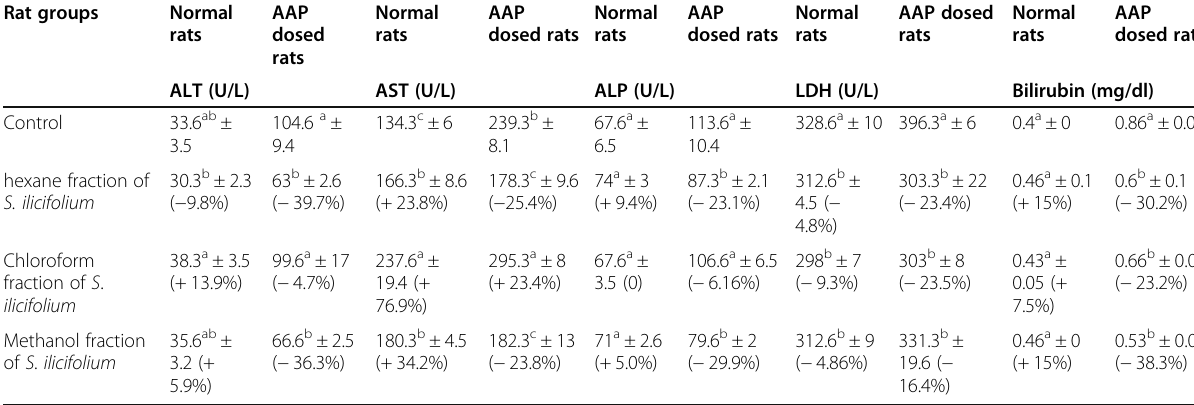
Table 1 Effect of n -hexane, chloroform and methanol soluble fractions of Sargassum ilicifolium on liver enzymes and bilirubin in normal and acetaminophen (AAP) dosed rats